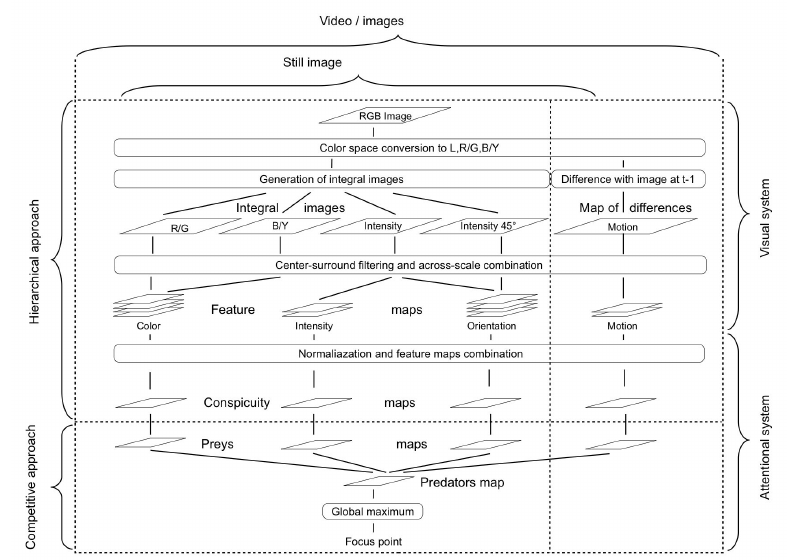
Figure 2. Schematic view of the proposed model of visual attention. After a first step similar to Itti [15] work, a prey- predator approach optimally fuse the information from different conspicuity maps.